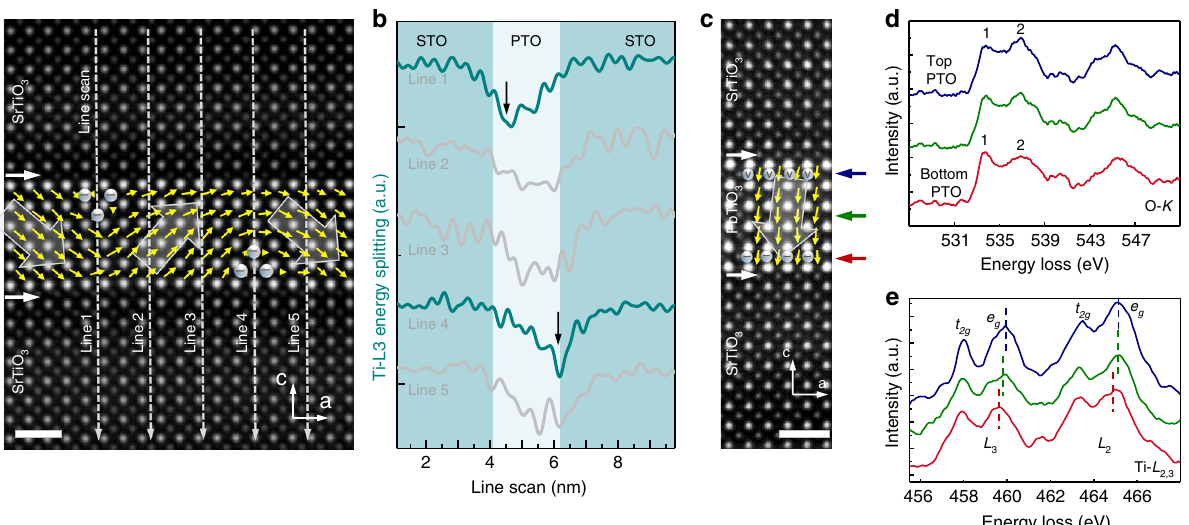
Fig. 4 HAADF-STEM images and EELS characterization across the multilayer. a HAADF-STEM image of PTO (6) /STO (10) . The yellow arrows indicate the polarization direction. Line scan EELS were performed across different regions of the wave domain. Scale bar, 1 nm. b Energy splitting value in the PTO and STO layers across the corresponding regions in a , showing that the Ti 3 + component is constrained in the wave opening. c – e HAADF-STEM image of the polar down region and corresponding EELS results of Ti – L 2,3 and O – K edges across the PTO layer. The blue, green and red curve are acquired at the regions indicated by arrows in c . The reference O – K spectrum acquired in PTO bulk could be seen in Supplementary Fig. 11. Subtle changes are observed as a result of an electronic-structure reconstruction. These results provide evidence for the appearance of oxygen vacancies on the negative polar interface of PTO and Ti 3 + component on the positive polar interface. Scale bar, 1